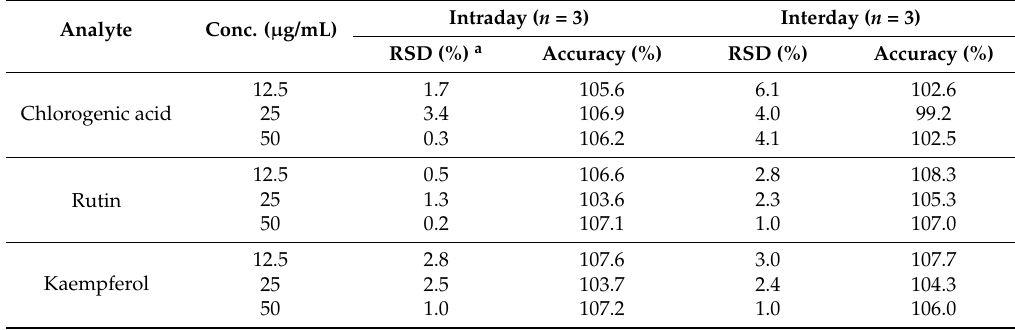
Table 3. Analytical results of intraday and interday precision and accuracy.